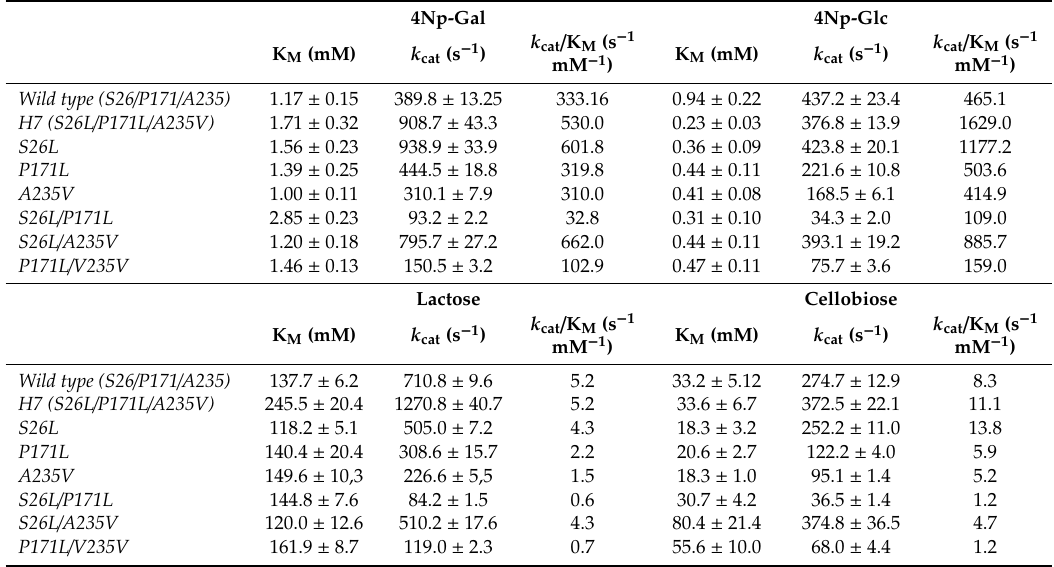
Table 1. Steady state kinetic constants at 65 ◦ C of Saccharolobus solfataricus ( Ss β -gly) wild type and